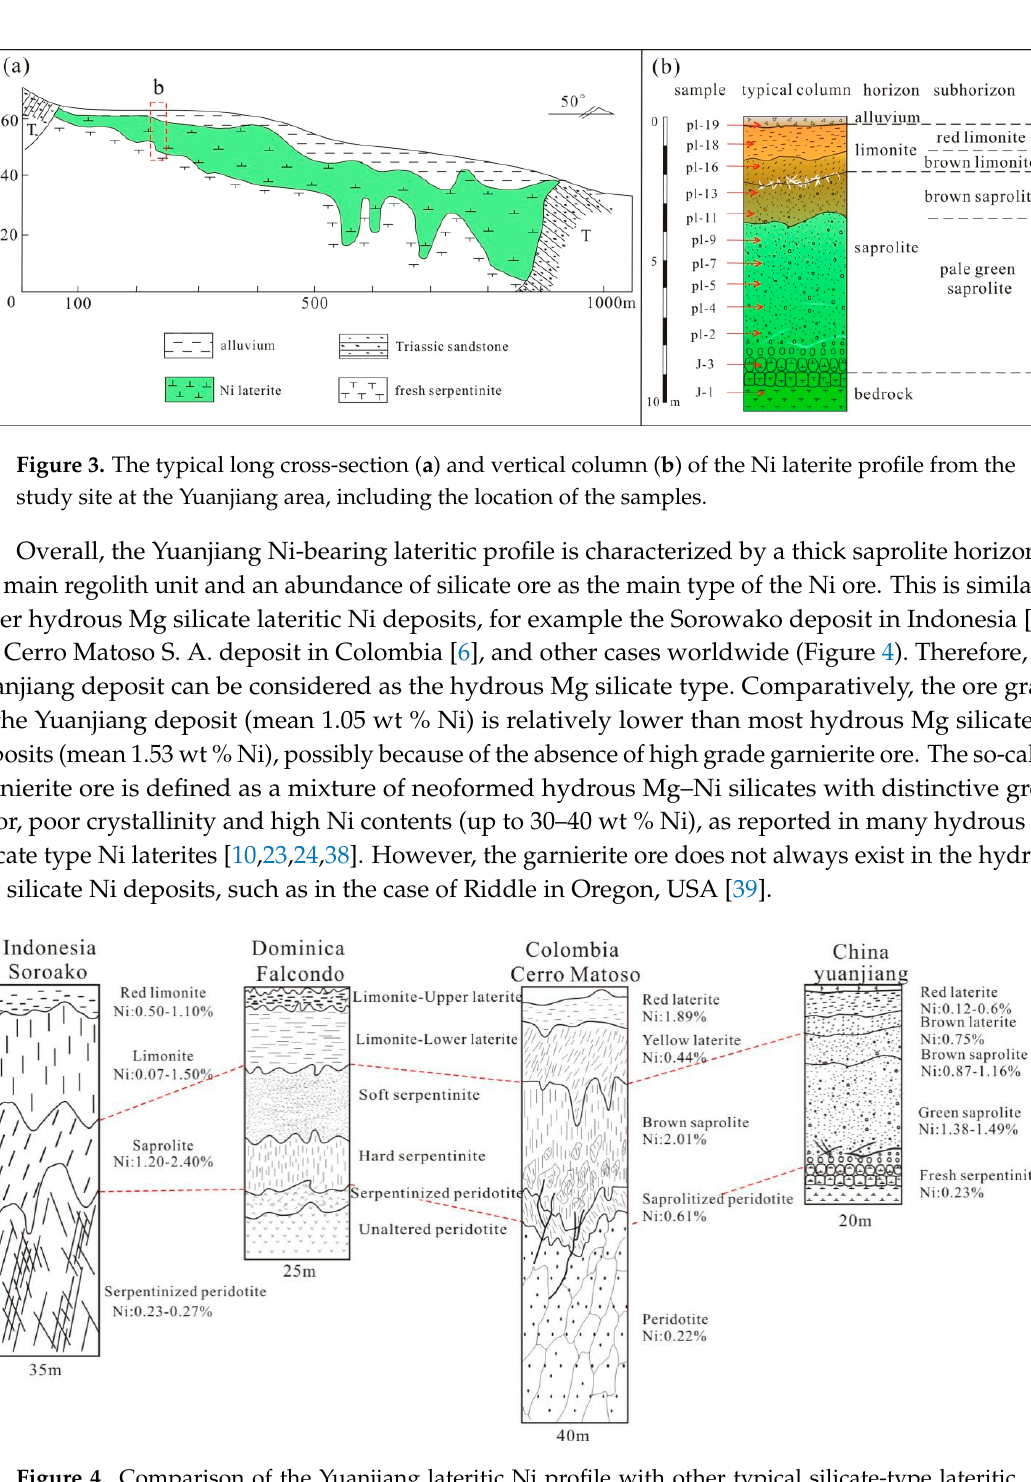
Figure 4. Comparison of the Yuanjiang lateritic Ni profile with other typical silicate-type lateritic Ni profiles around the world, including the Soroako profile in Indonesia [40], Falcondo profile in Dominica [9,41], and Cerro Matoso profile in Colombia [6]. The dotted lines show the boundaries of the saprolite horizons hosted silicate ore within the lateritic profiles from different sites.